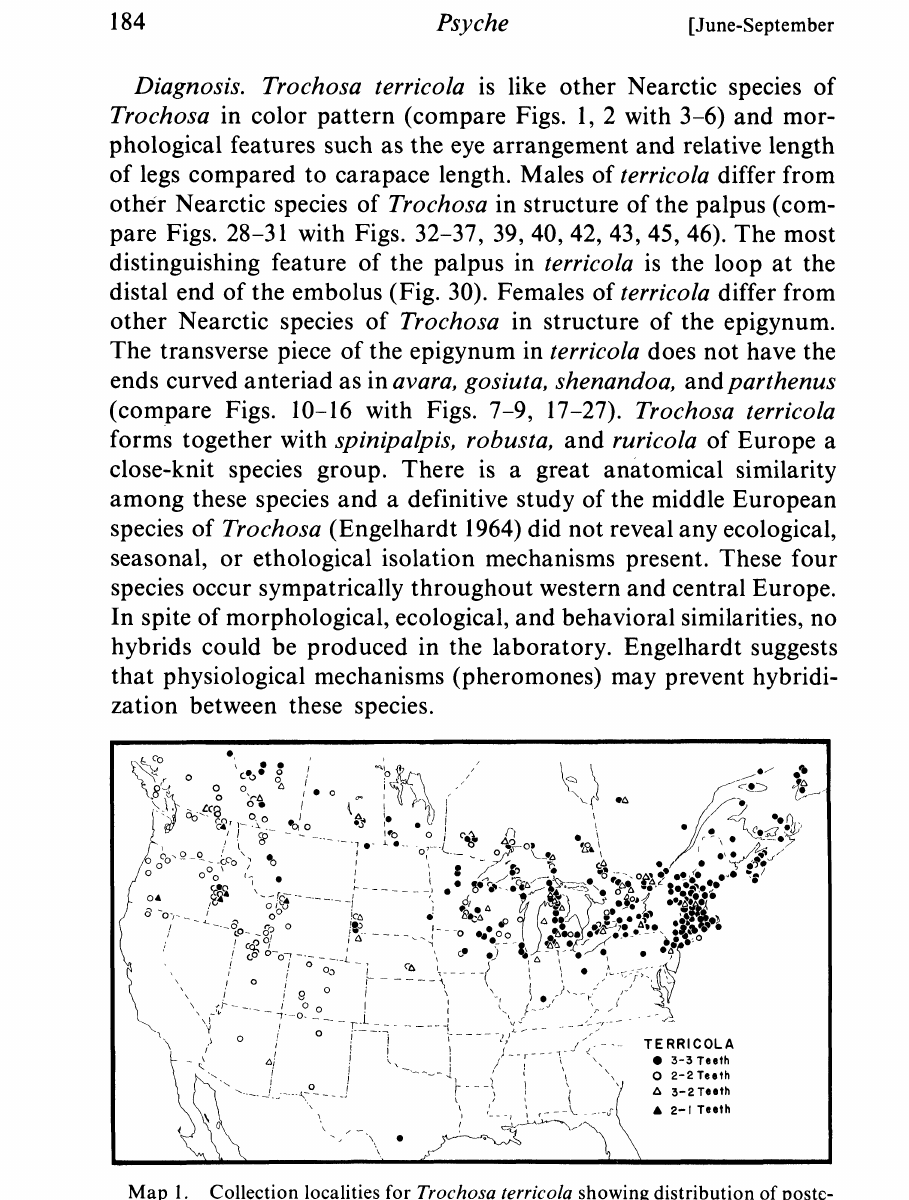
Map 1. Collection localities for Trochosa terricola showing distribution of poste- rior cheliceral teeth. Alaskan and northern Canadian localities not on map are listed under Records and marked with